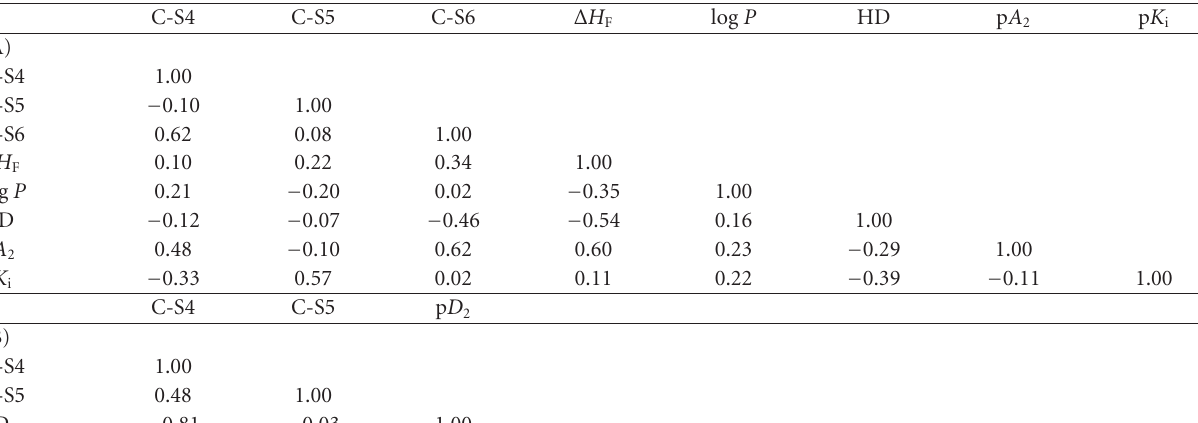
Table 6: Correlation matrix of the biological activity ( pK i , pA 2 , and pD 2 ) and molecular descriptors used in (A) ((5) and (15)) and (B) (6).